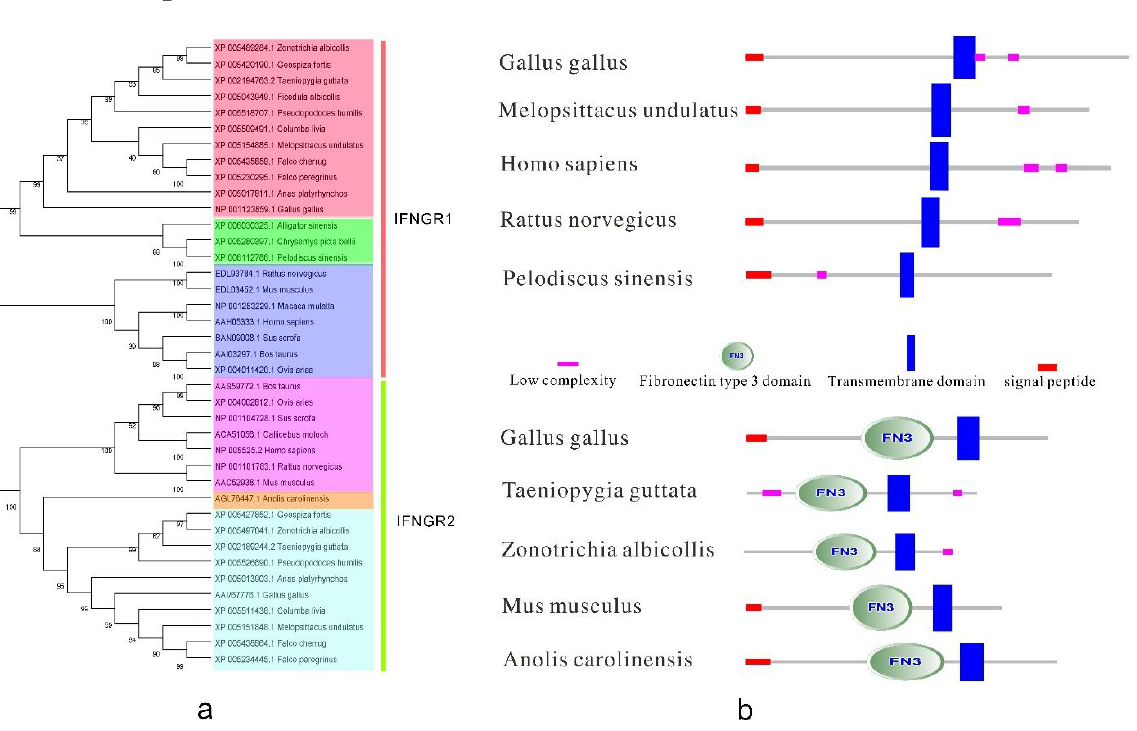
Figure 5. The phylogenetic tree and the protein structure of bird type II IFN receptors. ( a ) The phylogenetic tree of the type II IFN receptors. It was built by MEGA5 program with 1000 bootstrap replicates and based on the neighbor-joining method. For IFNGR1, dark orange, green, pink in the picture represent birds, reptiles and amphibians, mammals, respectively. For IFNGR2, pink, light orange, light blue in the picture represent mammals, reptiles and amphibians, birds, respectively; and ( b ) The structure of bird type II IFN receptors. IFNGR1 reference sequences: Gallus gallus [GenBank: NP001123859.1],